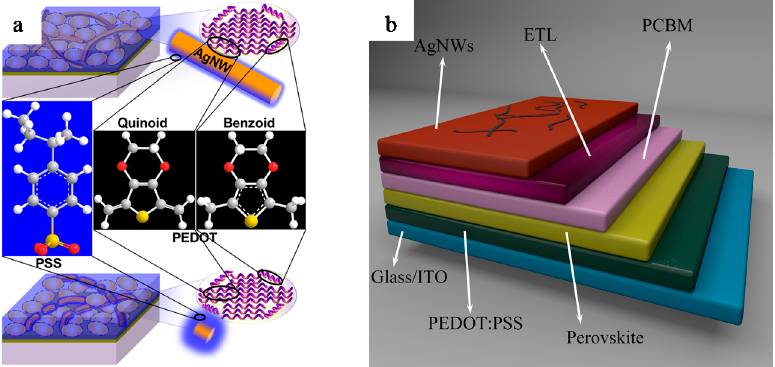
Figure 7. ( a ) AgNWs embedded in PEDOT: PSS. Reprinted with permission from [1]; Copyright 2018 American Chemical Society. ( b ) Schematic structure of the devices with spray coated top AgNWs. Reprinted with permission from [79]; Copyright 2018 Elsevier.